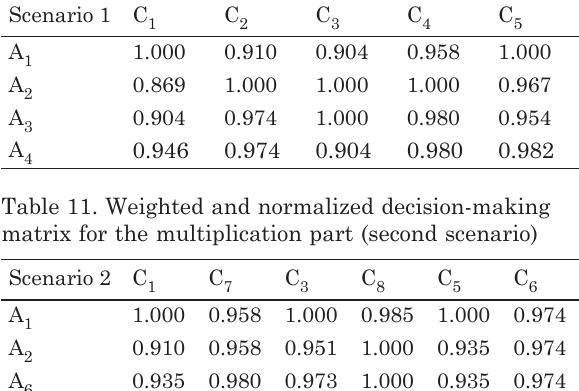
Table 10. Weighted and normalized decision-making matrix for the multiplication part (first scenario)